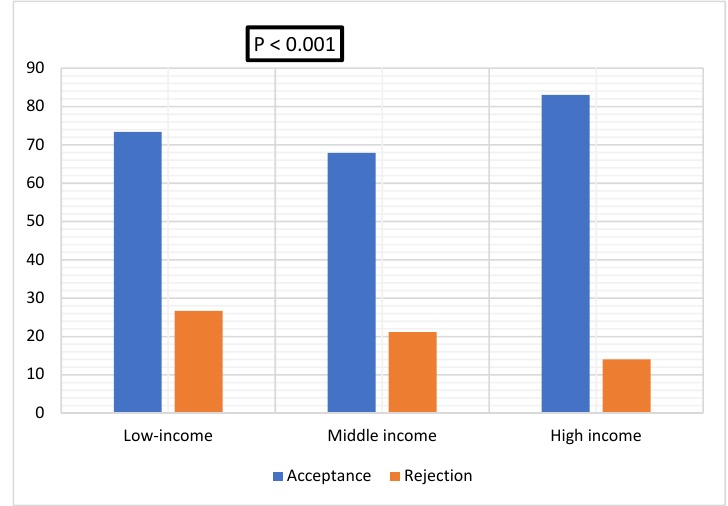
Figure 2. Acceptance of COVID-19 vaccine booster dose across different countries of the East Mediterranean Region based on their income level.